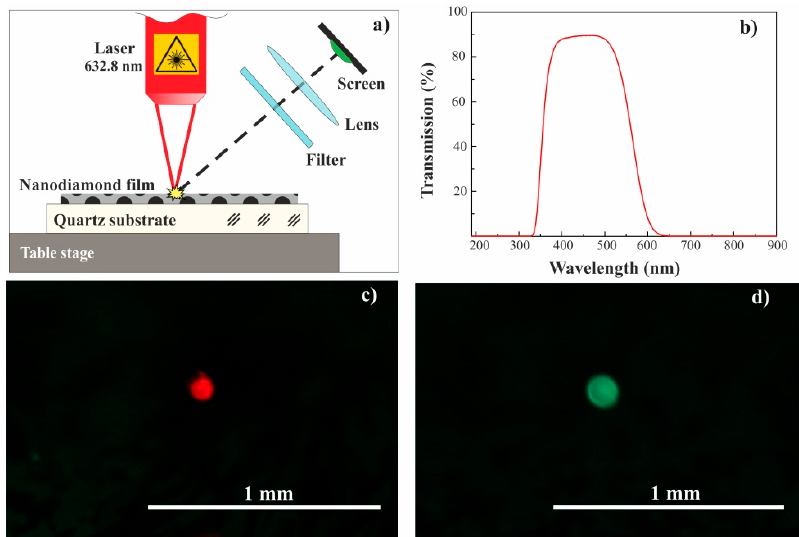
Figure 5. ( a ) A diagram of the experiment; ( b ) a transmission spectrum of the glass filter used to get images of the laser exposure area; the images of the laser beam spot at ( c ) 5.4 kW / cm 2 (no emission, only reflected red light) and ( d ) 65 kW / cm 2 (green emission is present).